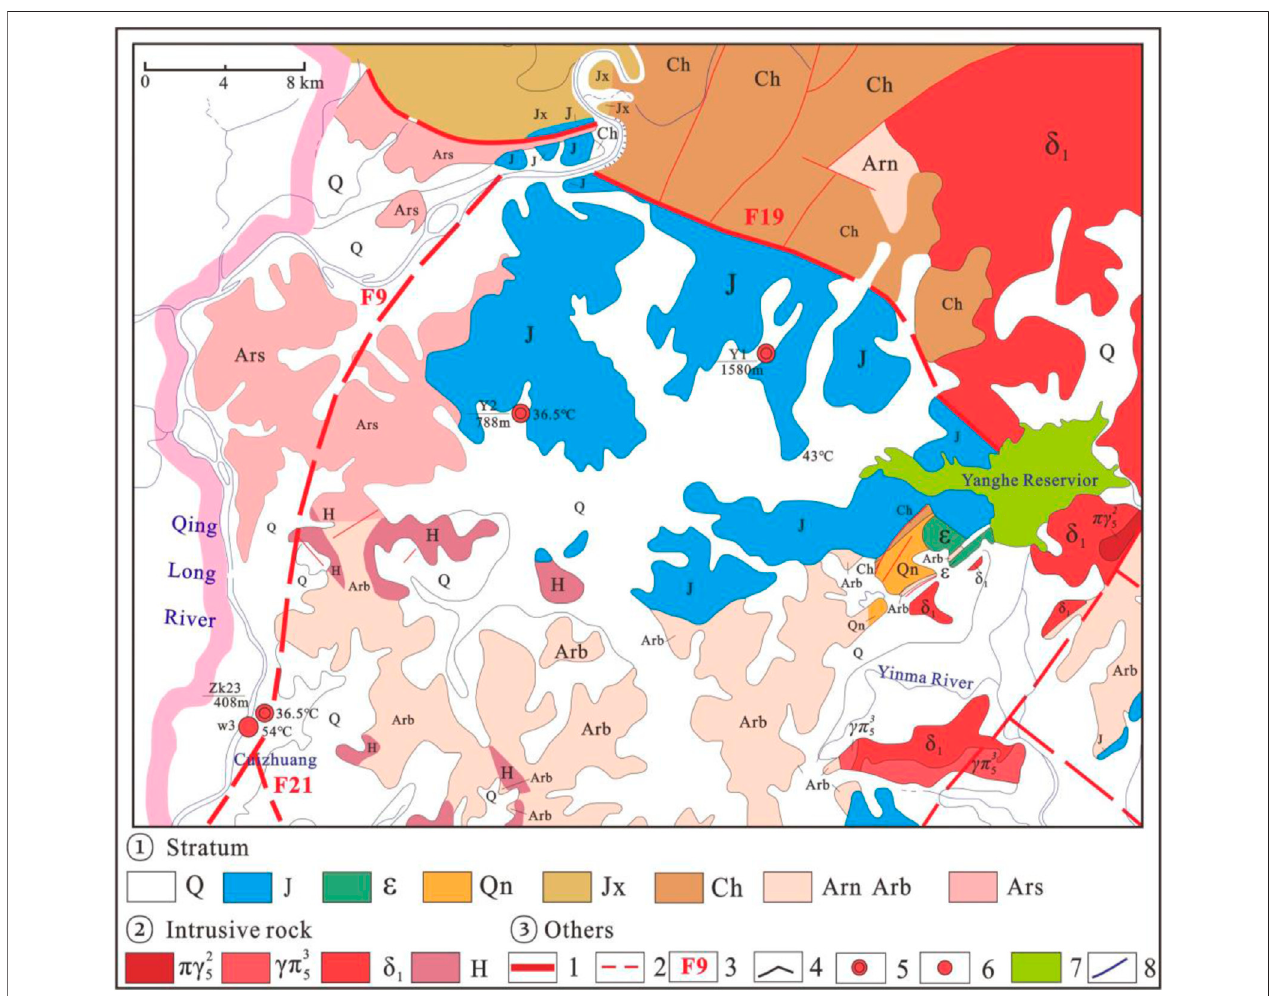
FIGURE 2 | Simpli fi ed geothermal geology of the Yanheying Basin (the location of the study area is de fi ned in Figure 1 ).